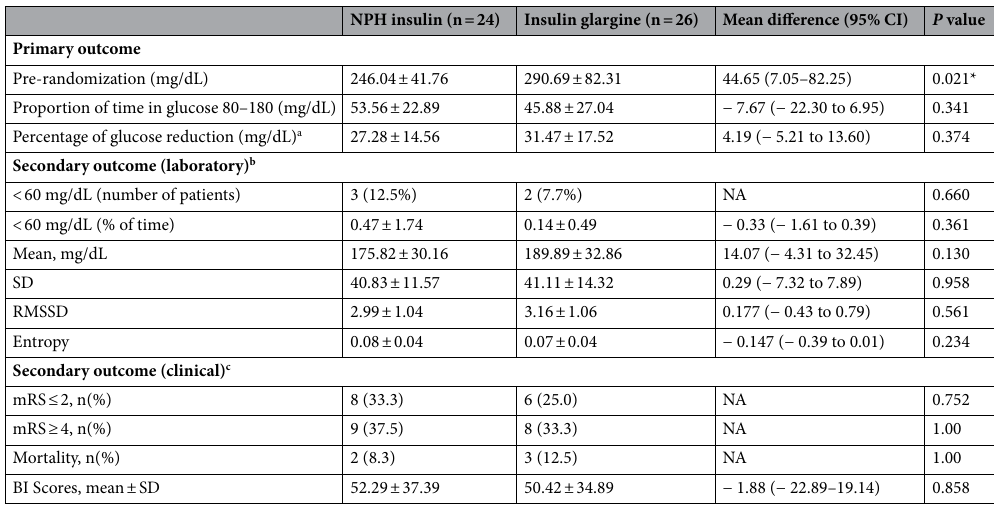
Table 2. Study outcome between treatment groups. Data was expressed as number (proportion) or mean ± standard deviation. NPH neutral protamine hagedorn insulin, SD standard deviation, RMSSD root- mean-square of successive beat-to-beat differences, mRS modified Rankin scale, BI Barthel index, NA not available. a Glucose reduction in comparison to pre-randomized glucose level. b n = 24 in Glargine group because two subjects were lost of follow-up. c n = 23 and 25 in two groups, respectively, due to two subjects with